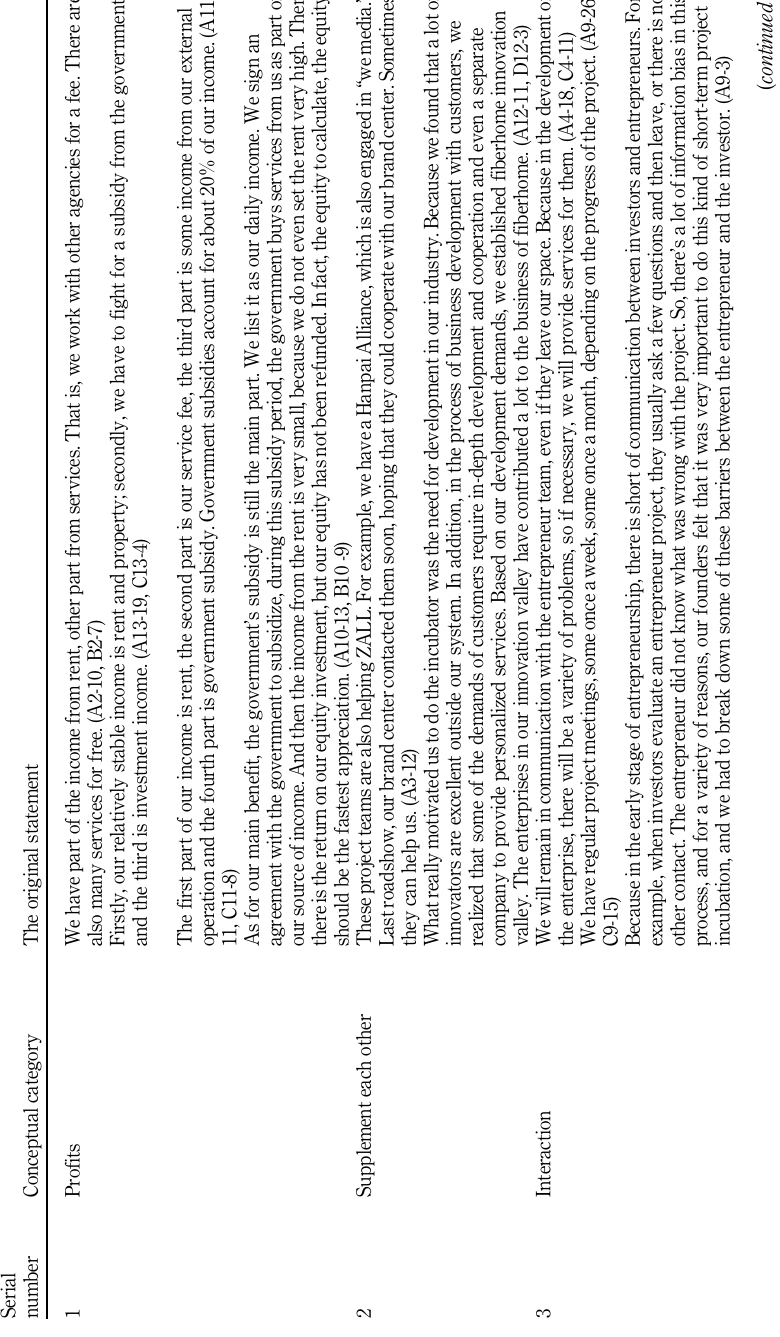
Table 3. Open coding of makerspace ecosystem operation